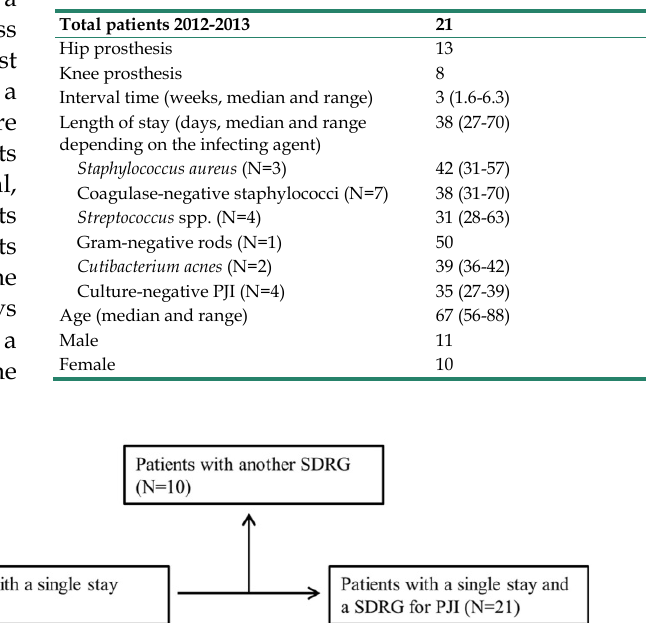
Table 3. Patient’s demographic characteristics.